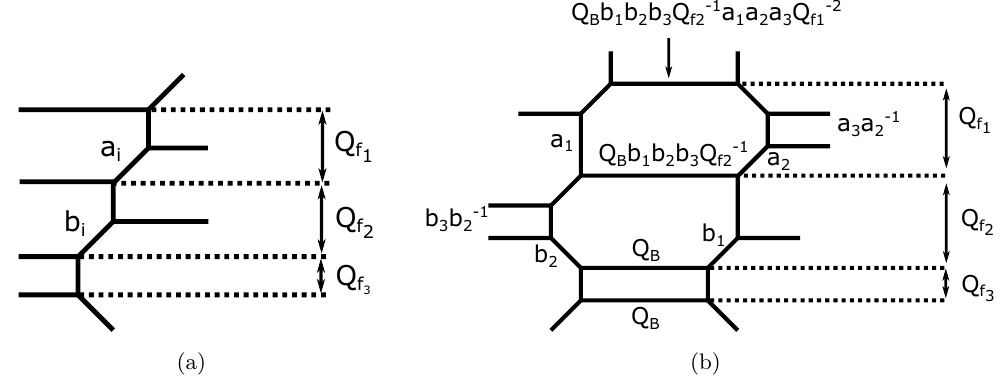
Figure 53. (a). The local diagram for one of the tree parts which form the trivalent SU(4) gauging. i runs from 1 to 3 representing the three parts. (b). The local diagram which describes the SU(4) − 1 gauge theory with 6